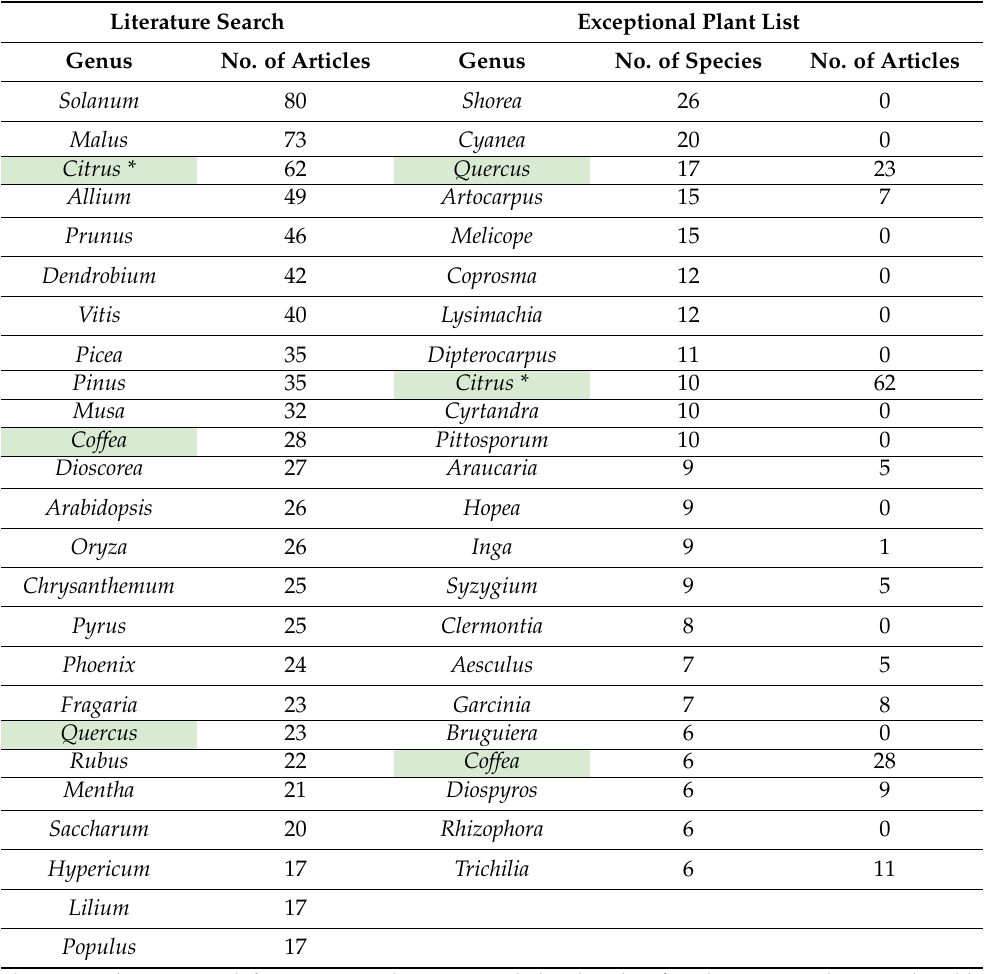
Table 2. The top 25 genera with the most Web of Science articles identified, compared with the 23 genera with six or more species listed in the current Working List of Exceptional Plants. Literature Search